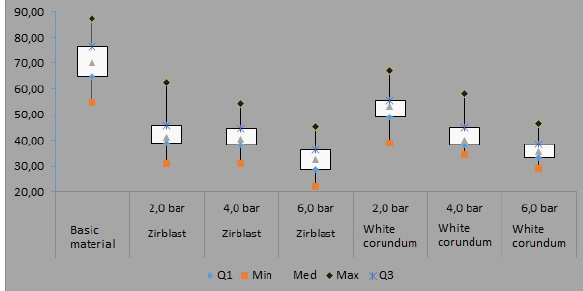
Figure 6: The effect of pressure on the value of the parameter Rt.